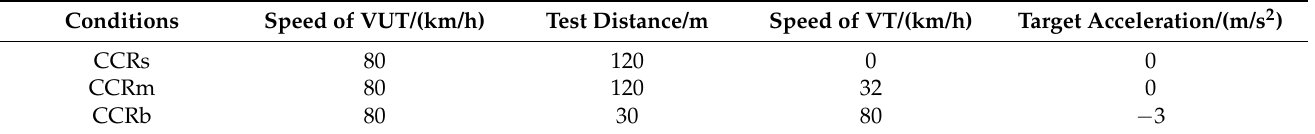
Table 5. Passenger car AEB test conditions.